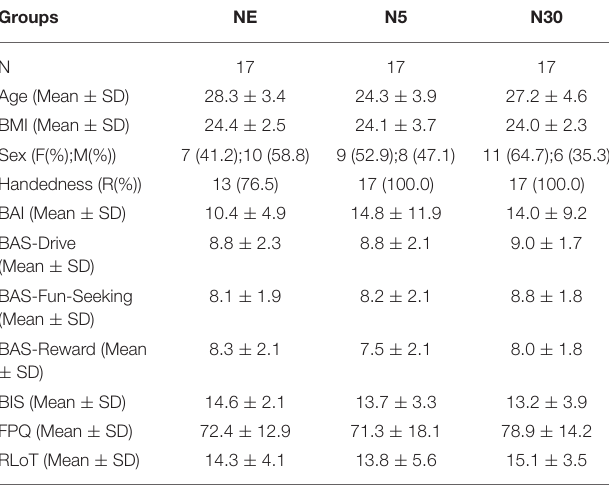
TABLE 1 | Participants’ descriptive characteristics and psychological